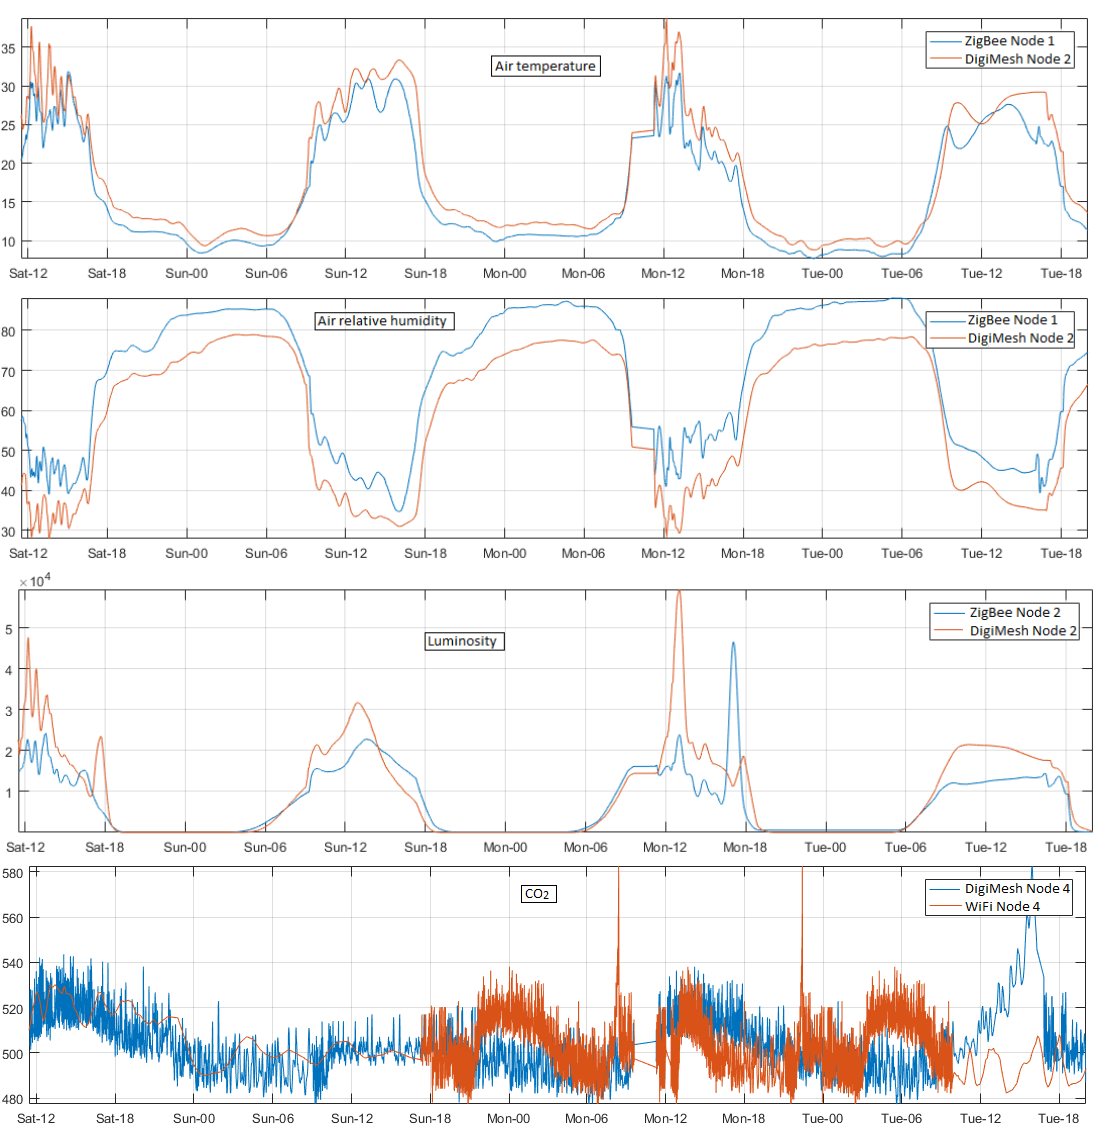
Figure 12. Temporal signals of the WSNs in different